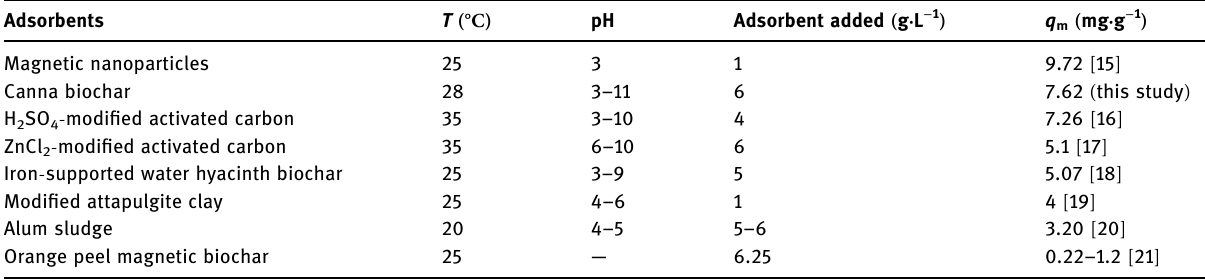
Table 1: Comparison of maximum phosphorus adsorption capacity of some adsorbents